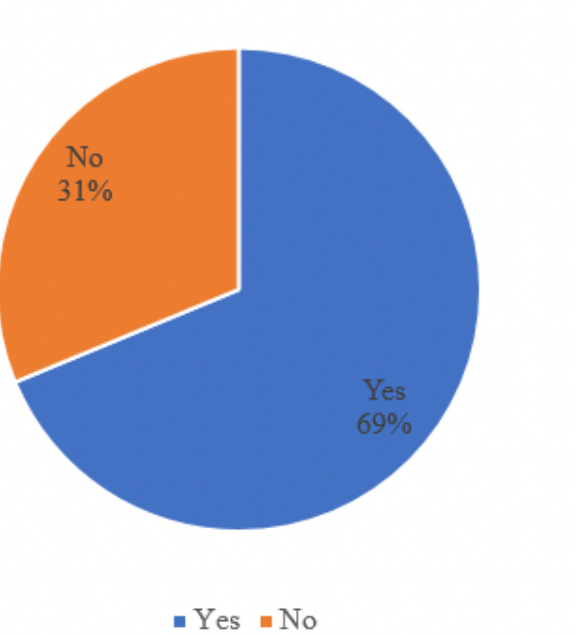
Figure 6. How many studies used machine learning